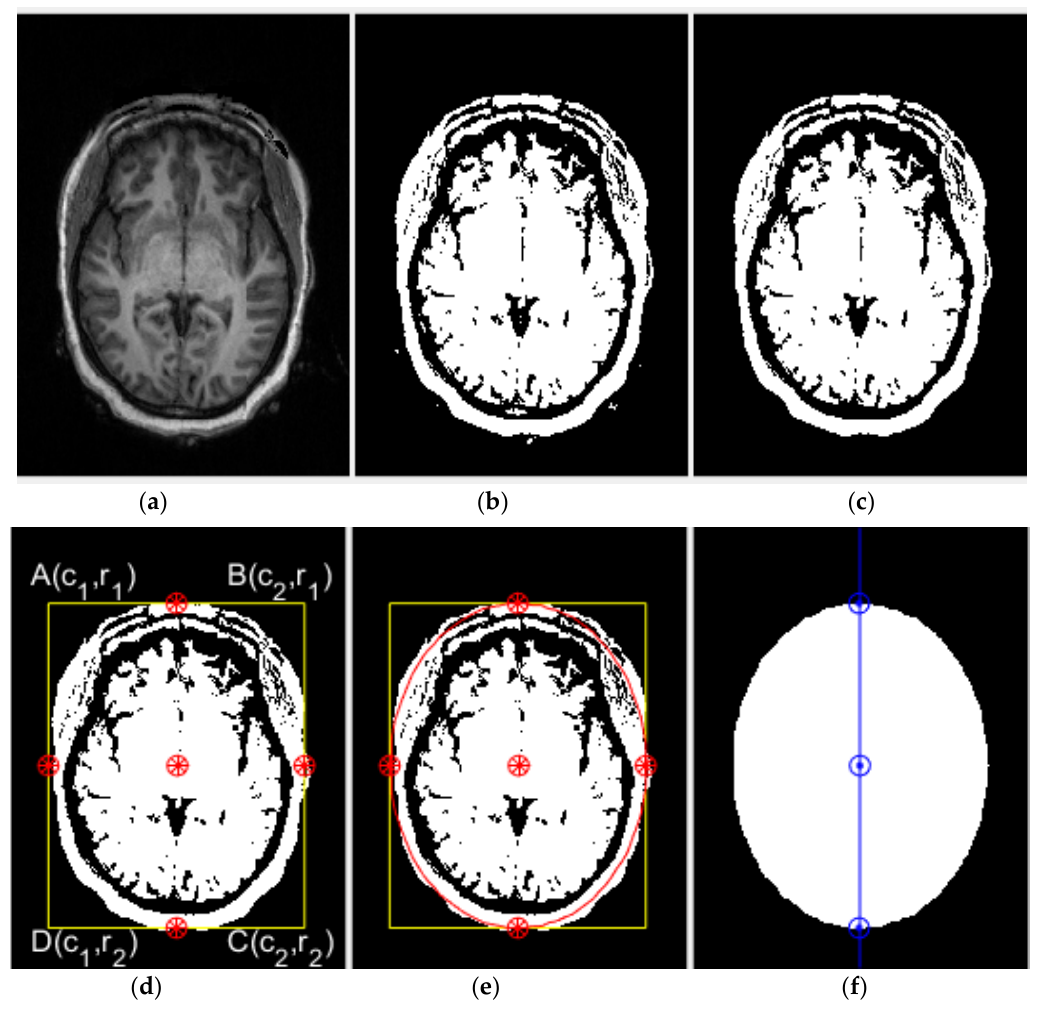
Figure 6. Elliptical area extraction. ( a ) Input image, ( b ) binary image, ( c ) noise removal, ( d ) rectangular boundary extraction, ( e ) elliptical area extraction, and ( f ) symmetric axis (midline) extraction using PCA.